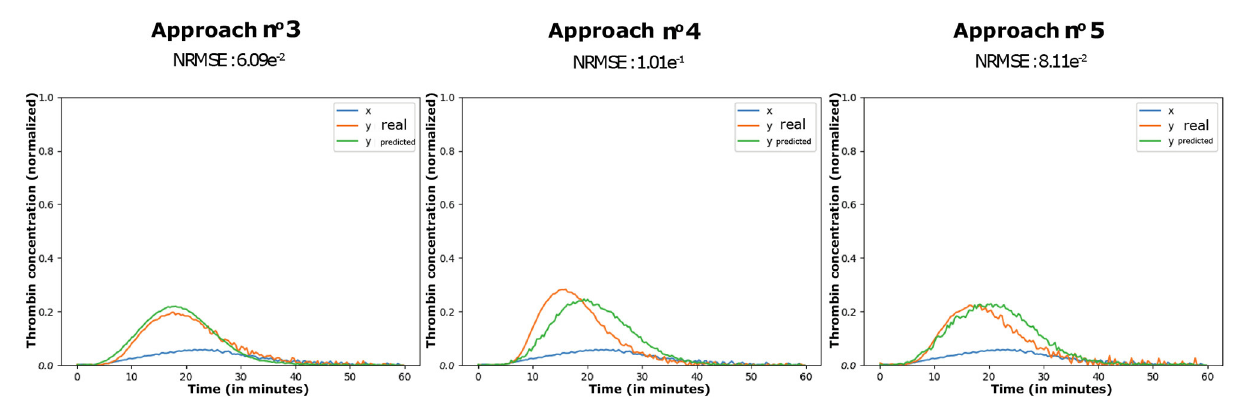
FIGURE7 Representation of the error rates associated with Table